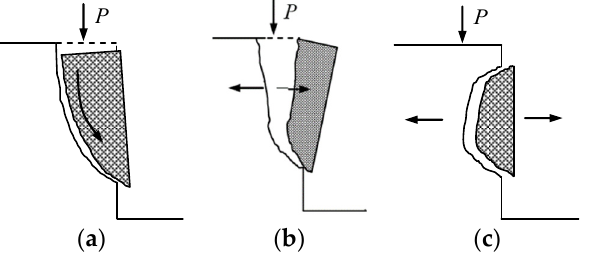
Figure 1. Failure form of coal wall spalling: ( a ) tensile crack failure; ( b ) bulging failure; ( c ) shear failure.